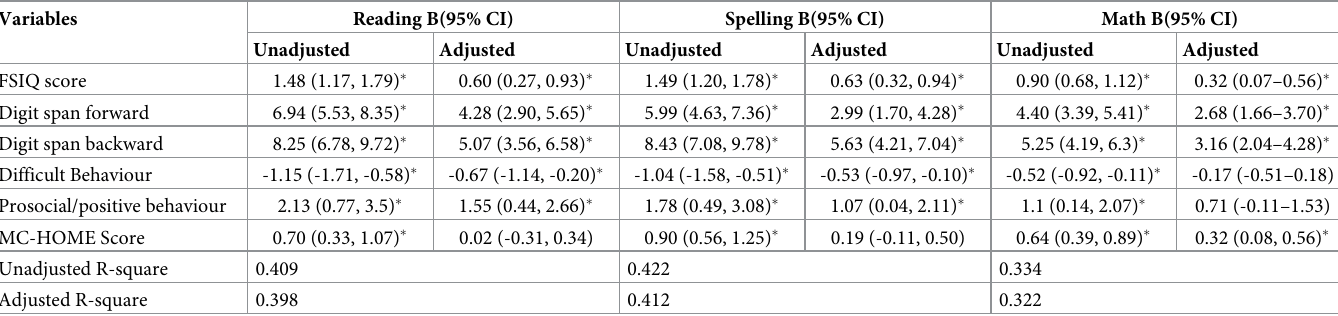
Table 4. Unadjusted and adjusted multiple linear regression analysis of developmental status on school achievement score.